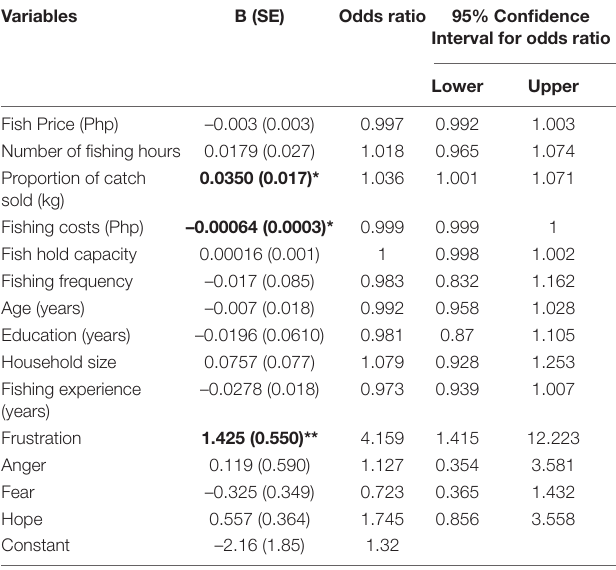
TABLE 3 | Factors that are influencing the change in the volume of fish catch during the time of Pandemic in Davao Gulf (Significantly different factors are in bold).